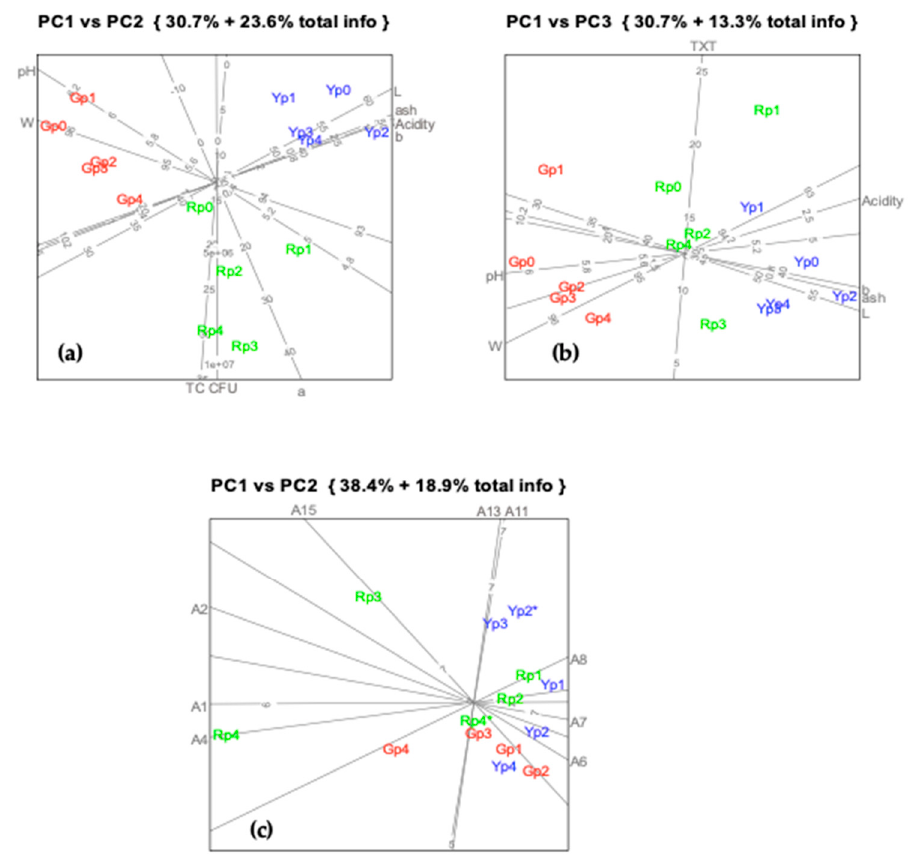
Figure 6. Predictive biplots of physicochemical, microbiological and sensory data over storage time applied to the plane PC1 vs PC2 to evaluate quality changes over storage time: ( a ) PC1 vs PC2 plot presenting most important variables and its relations (pH, moisture content (W), titratable acidity, ash content, microorganisms (CFU), total carotenoids (TC) and color parameters ( a , b and L )); ( b ) PC1 vs PC3 plot presenting important variables and its relations (pH, moisture content (W), titratable acidity, ash content, and color parameters b and L and texture (TXT)); ( c ) PC1 vs PC2 plot presenting products attributes: surface moisture (A1), typical color (A2), brightness (A4), elasticity (A6), cohesiveness (A7), hardness (A8), firmness at first bite (A11), flavor typicity (A13), sourness (A15). Axis scales correspond to initial attributes values representing the scale used. Letters identify product type: Gp = green peppers, Rp = red peppers, Yp = yellow peppers associated to numbers (0 to 4) corresponding to sampling/storage time (5; 10; 14; 17 days, respectively). Axis scales correspond to initial variables values.